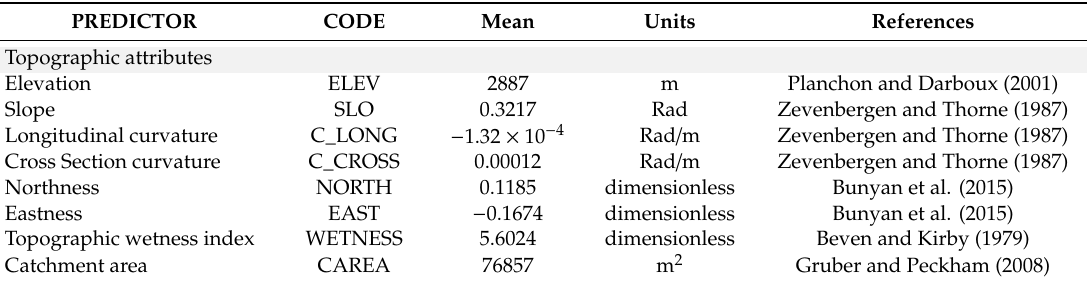
Table 2. List of digital elevation model (DEM) derived